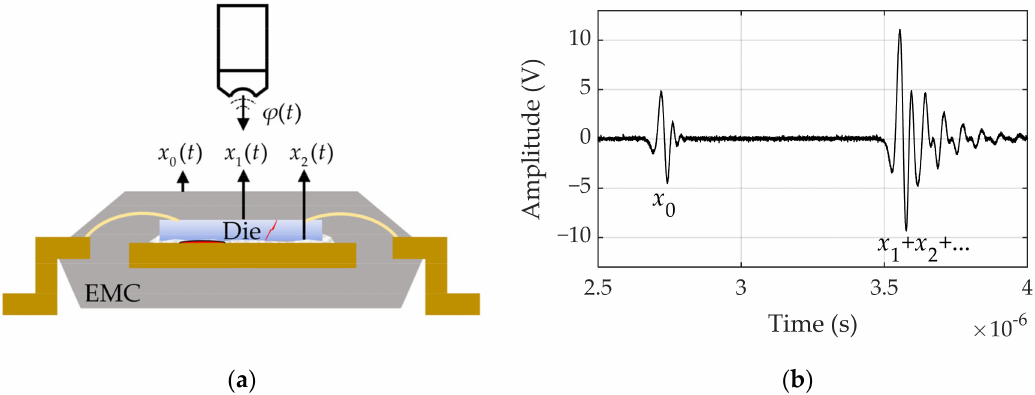
Figure 1. Scanning acoustic microscopy of electronic packages: ( a ) common structure of electronic packages; ( b ) acoustic microimaging (AMI)